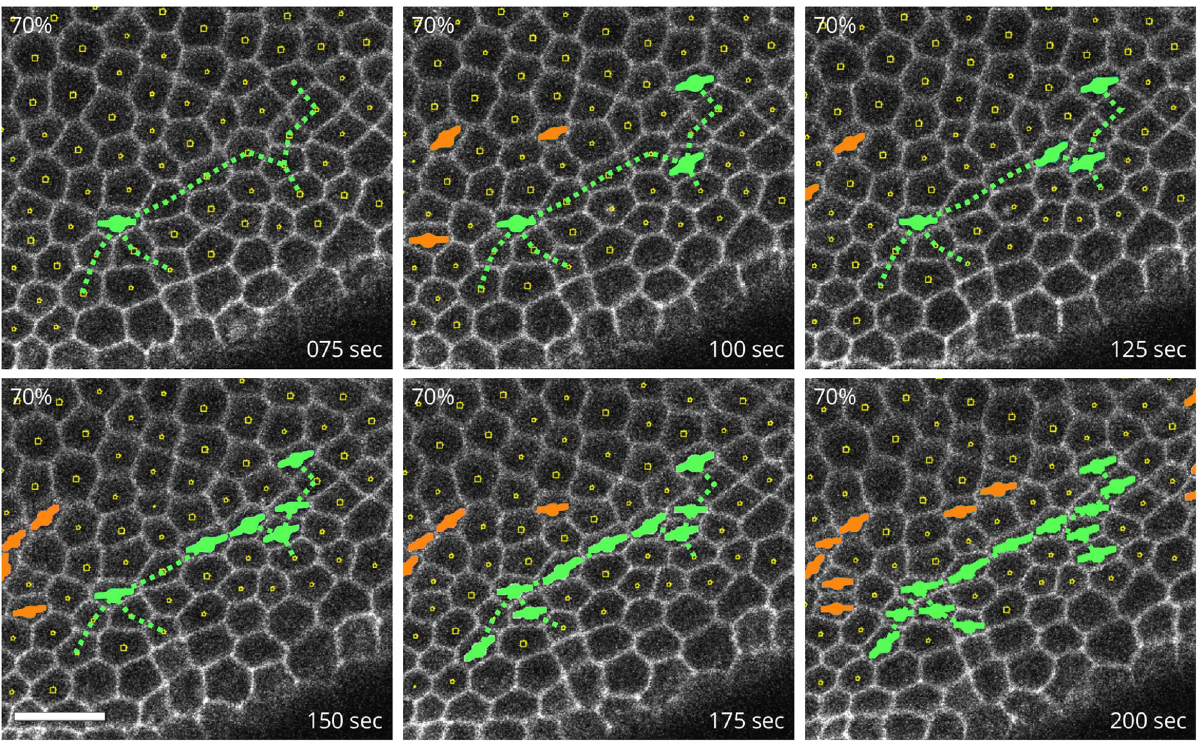
Fig 7. Piecewise formation of a cellular constriction chain. Processed confocal microscopy images of the ventral side of a Spider-GFP embryo during the initial slow apical constriction phase of VFF. The constricted cells highlighted in green initially form linearly arranged singlets and doublets, which are later connected into a single constriction chain. The dotted line indicates the final chain connectivity. Constricted cells are identified using the threshold r c = 0.70. Scale bar: 10 μ